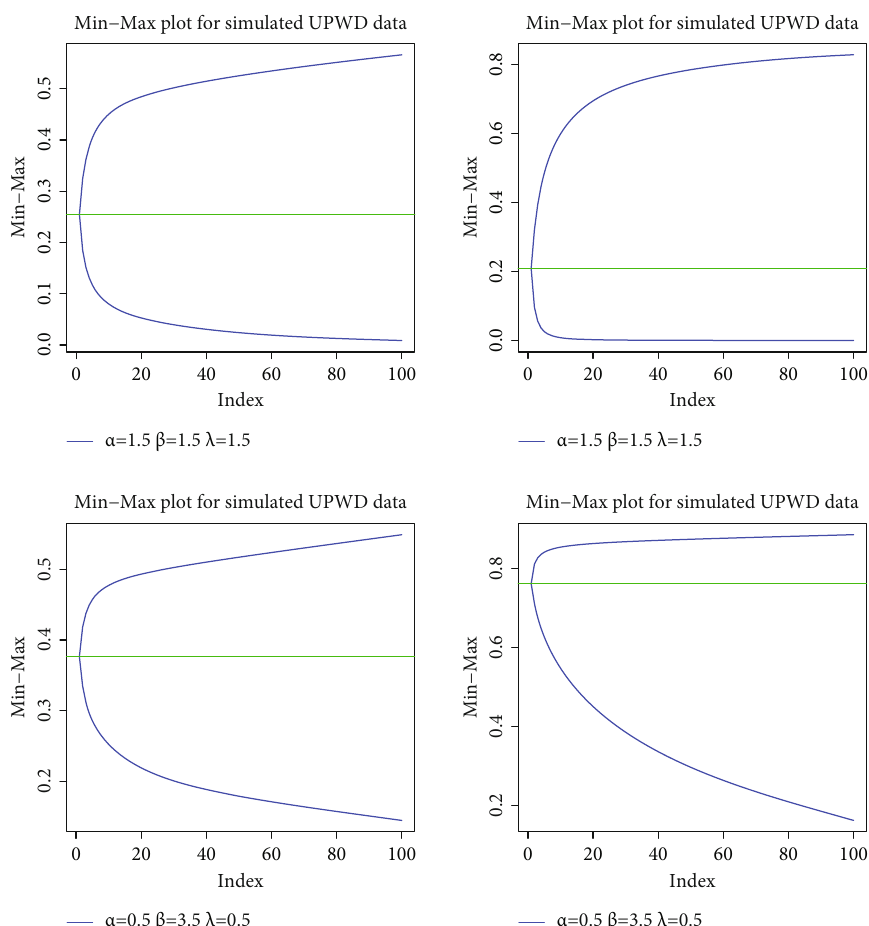
Figure 7: Min – Max plot of order statistics of UPWD model for some parametric